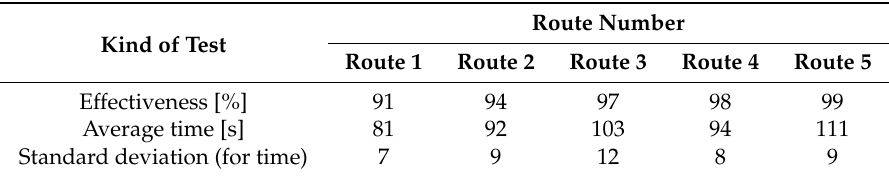
Table 3. Transition results of the tested persons on 5 different routes in “learning”